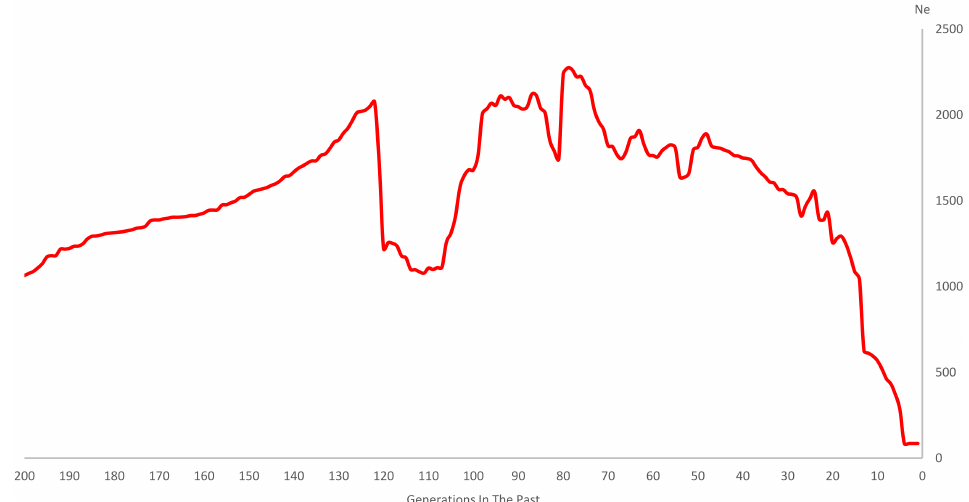
Figure 4. Genome-wide estimate of historical effective population size (Ne) over the past generations.